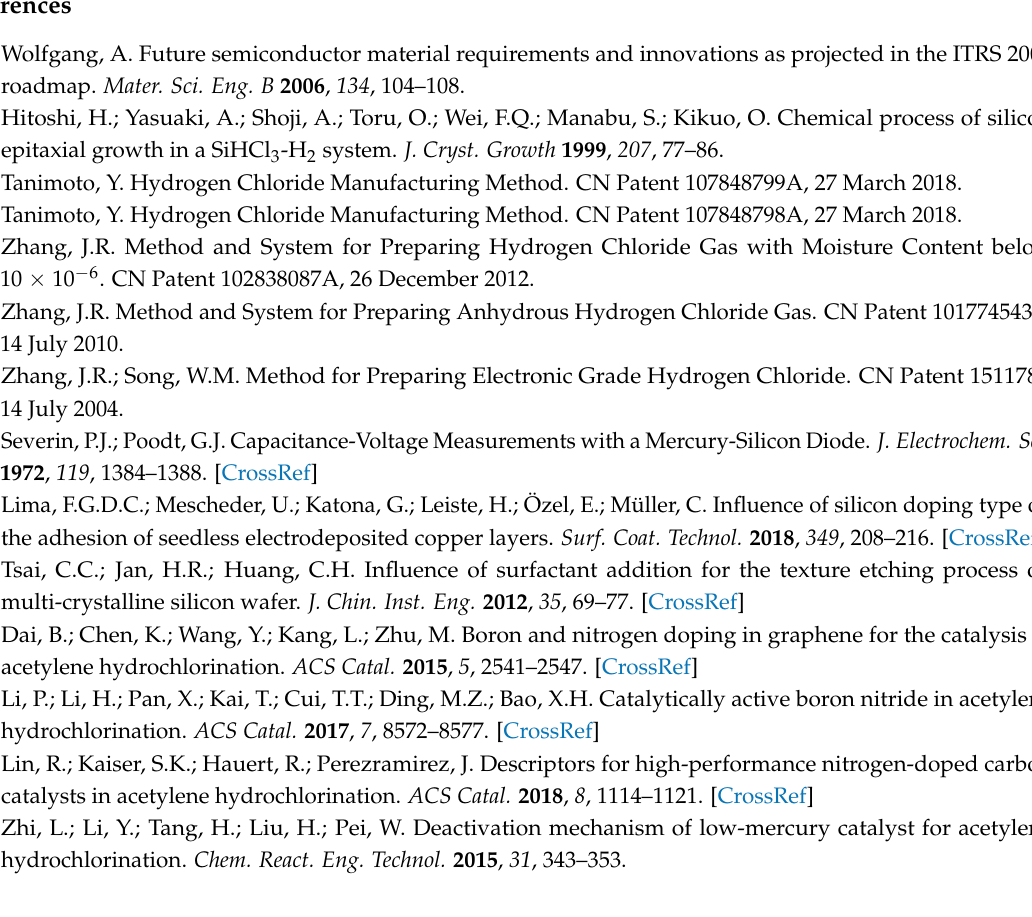
Figure S1. Pore size distributions of the AC substrates: (a) TX-AC (b) S20-AC (c) S40-AC (d) Fe0.8-AC (e) WG-AC; Figure S2. SEM images of the AC substrates: (a) TX-AC (b) S20-AC (c) S40-AC (d) Fe0.8-AC (e) WG-AC; Figure S3. XRD patterns of the substrates of Fe0.8-AC and S40-AC; Figure S4. EDS element analysis for the sample of ZS-SD1-Fe0.8-M, treated by HCl at T = 220 ◦ C for 60 h; Table S1. Elementary composition of the carbon powder (TX and HM); Table S2. Structure parameters of the AC substrates based on N2